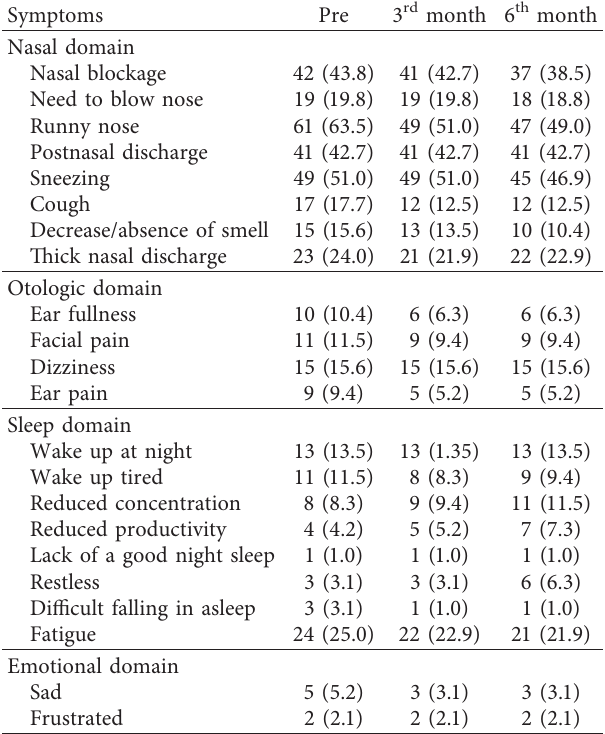
Table 3: Total SNOT-22 scores. Table 2: Symptom domains in